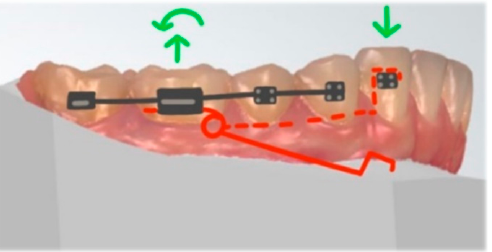
Figure 10. Cantilever activated for canine intrusion, placed on the top of the mandibular canine bracket (red: cantilever, green: force and moment).